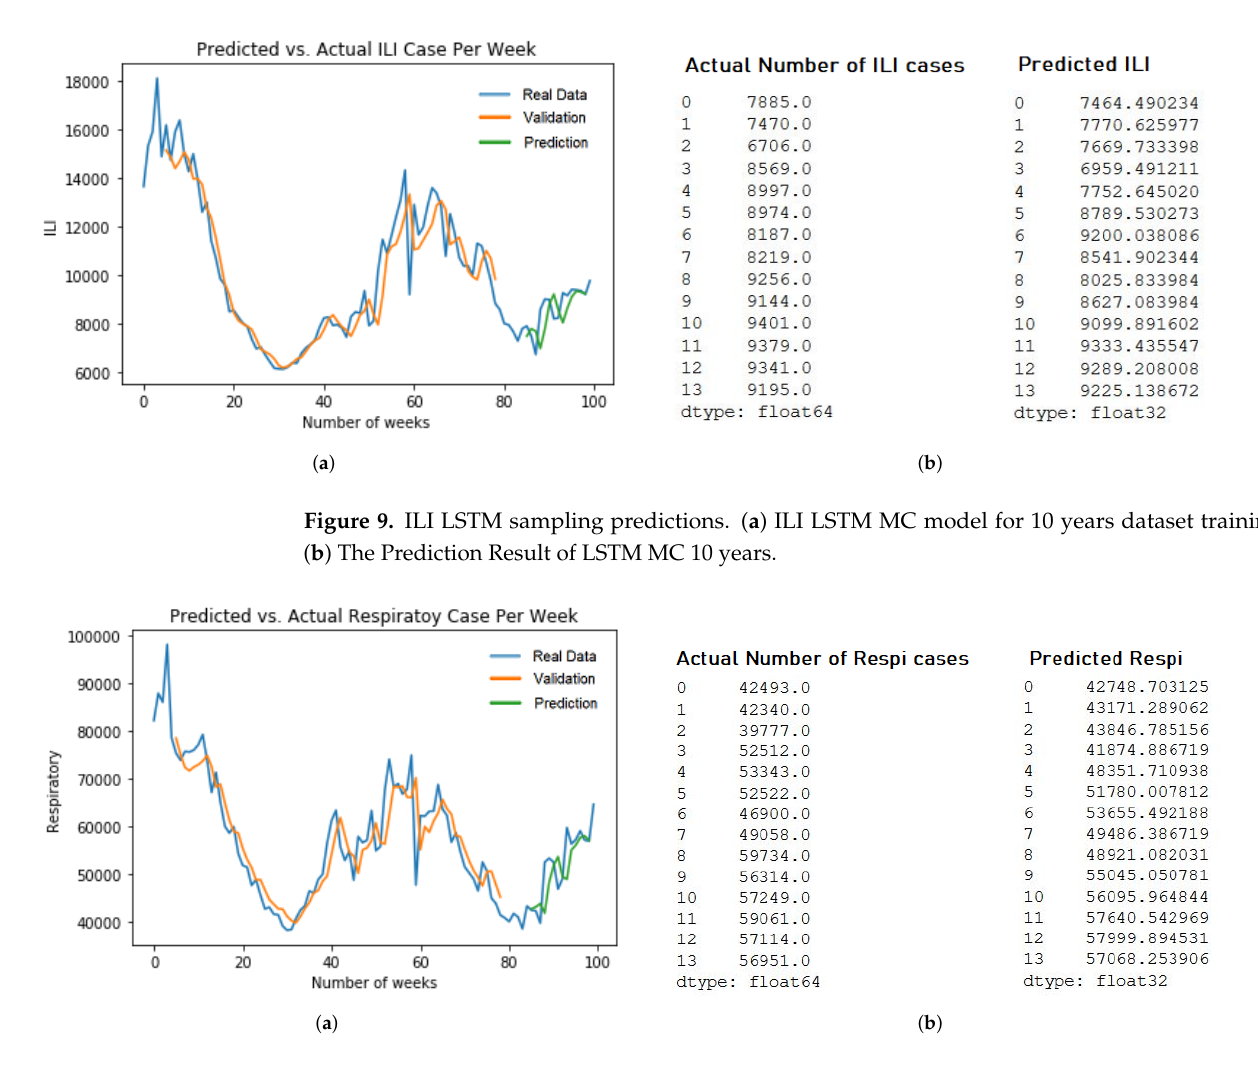
Figure 10. Respiratory LSTM sampling predictions. ( a ) Respiratory LSTM ALL model for 5 years dataset training; ( b ) The Prediction Result of LSTM ALL 5